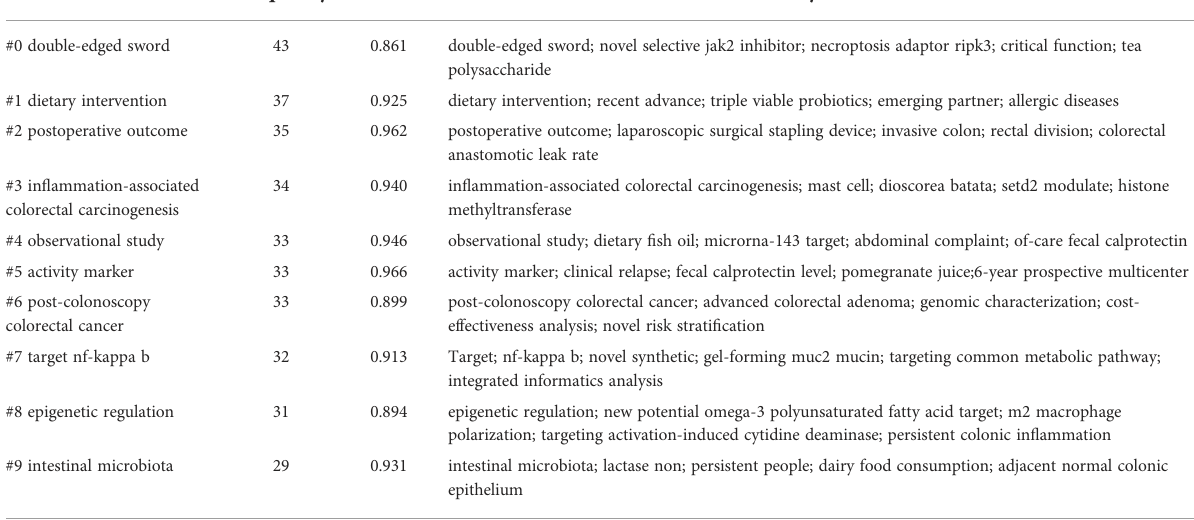
TABLE 3 Top 10 Keyword